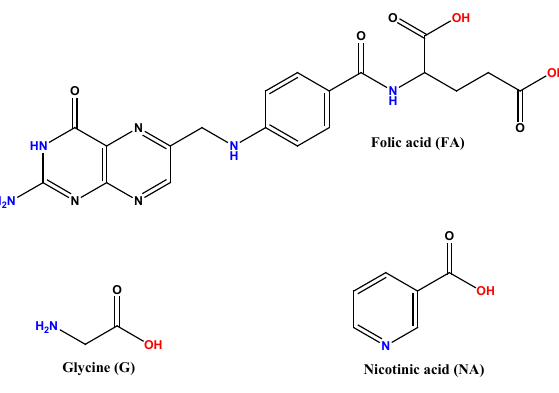
Scheme 1: Molecular Structures of the studied